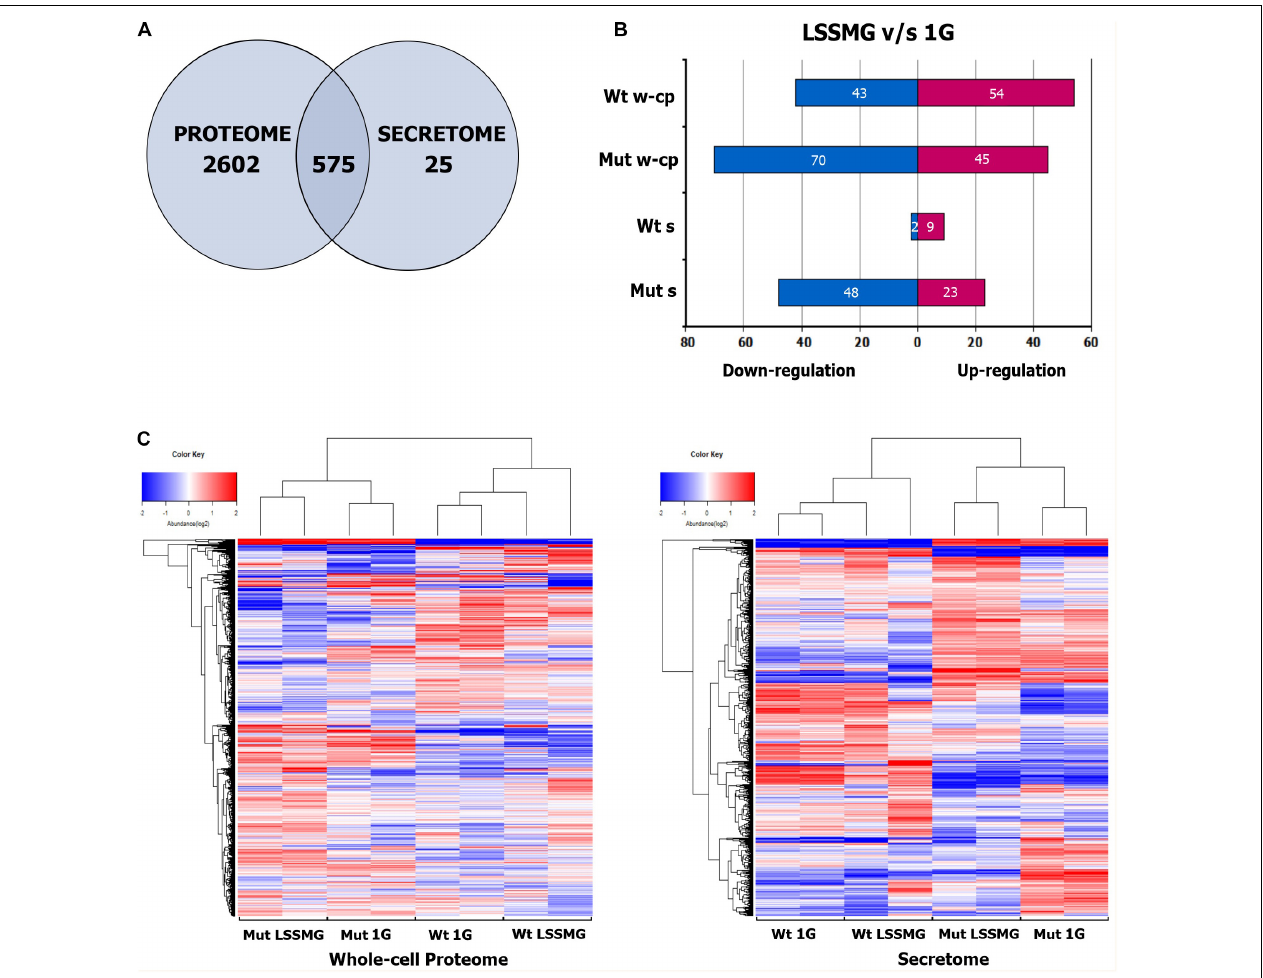
FIGURE 4 | Proteins identified and detected as regulated in the whole-cell proteome and secretome of Knufia chersonesos Wt and Mut following exposure to LSSMG. (A) Overlap of proteins between whole-cell proteome and secretome, identified in two separate TMT LC/MS experiments. (B) Number of differentially abundant proteins for each strain under LSSMG compared to 1G (control) (fold change of ≥ ± 1.5, p ≤ 0.05). (C) Heat map hierarchical clustering of co-varying proteins quantified in each strain. The color key indicates the values that represented the protein abundance ratio (log2) and the number of proteins counted in each value. A total of 6 runs – 3 technical replicates and 2 biological replicates – were performed for each sample. Wt, wild type; Mut, mutant; w-cp, whole-cell proteome; s, secretome. Heatmaps were generated using